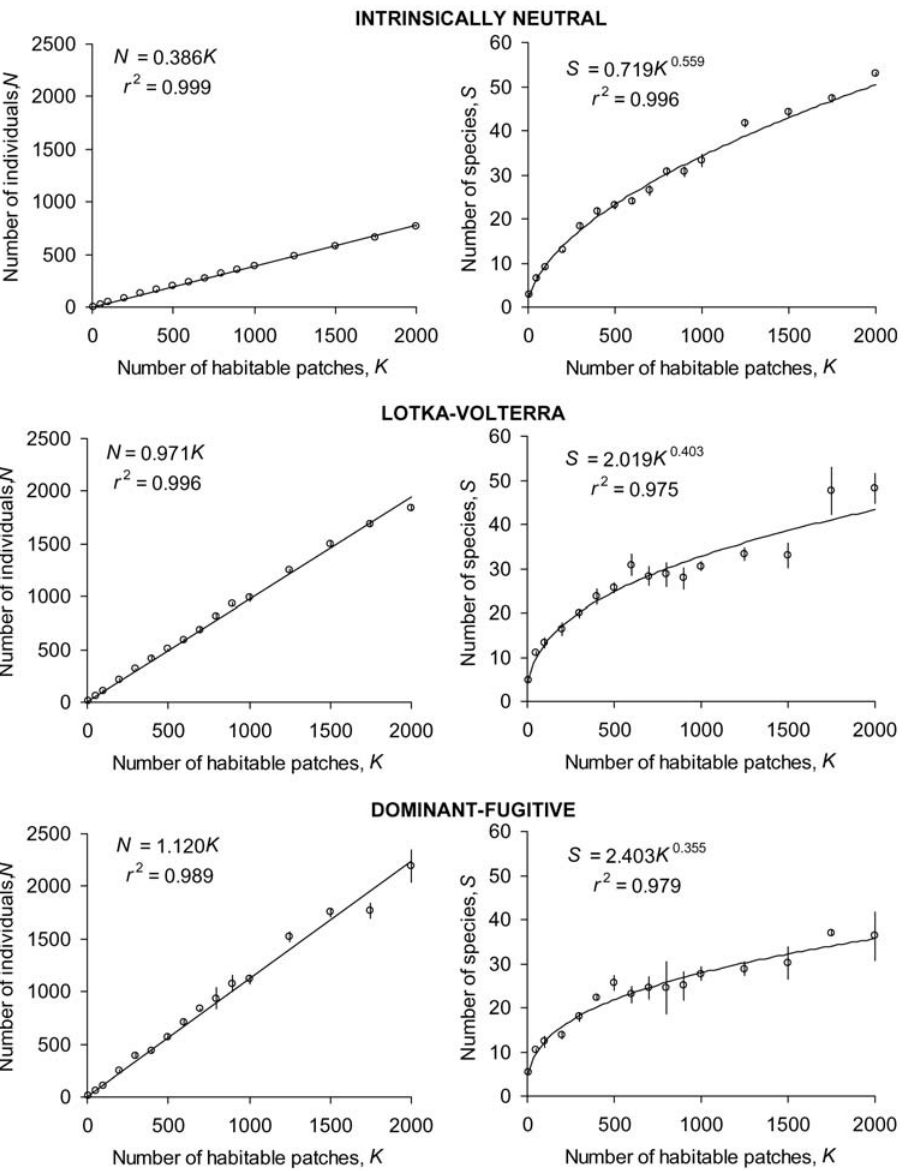
Figure 4. Simulated steady-states of species-area relationships (SARs). SARs each show mean 6 s.e. of three replicate communities. See Methods for input parameter values and the process of random species assembly.